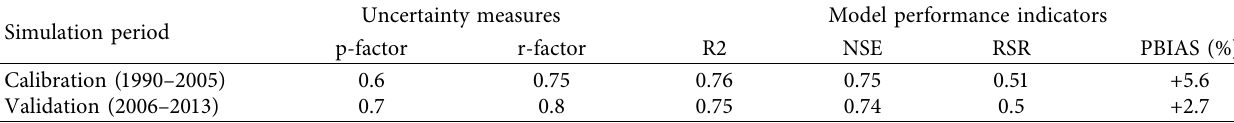
Table 7: General statistics of streamflow calibration and